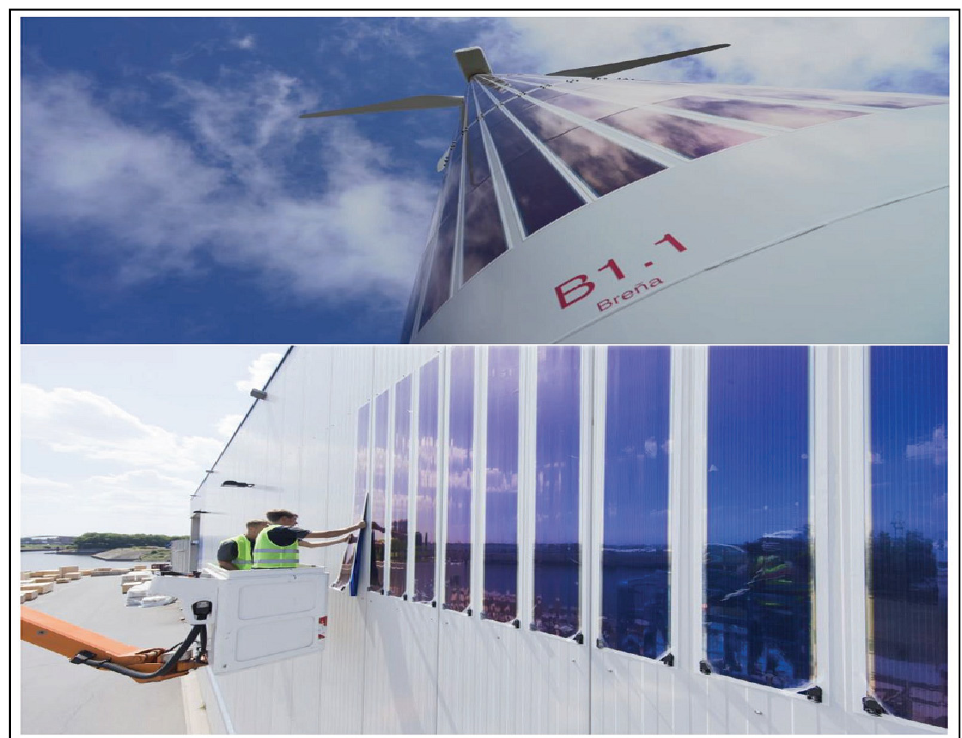
Figure 32. Heliatek’s solar panels on wind turbines. Bottom: ≈ 185 m 2 of Heliatek’s solar panels applied on an industrial building in the seaport of Duisburg, Germany.